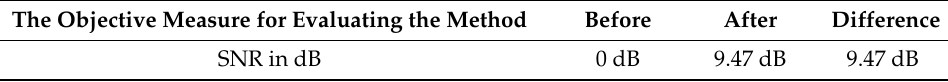
Table 1. SNR measure applied for evaluating the SSA method for wind noise reduction Measurement cases and difference.